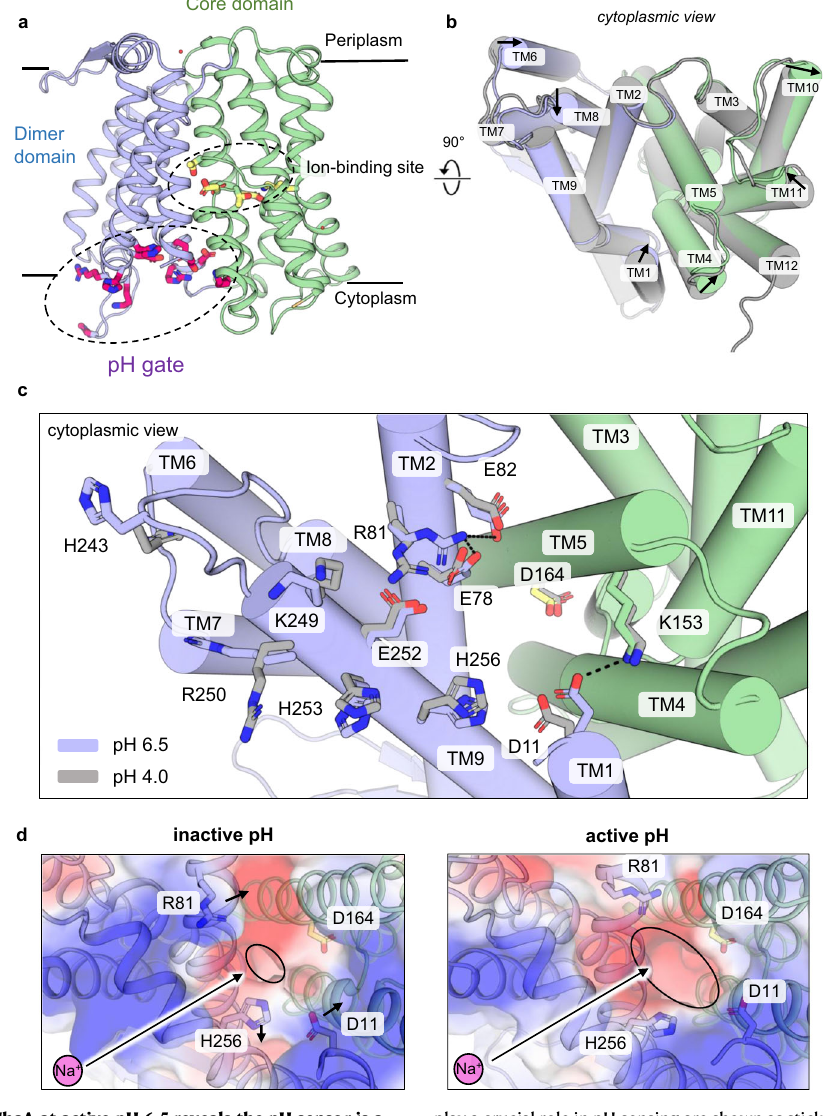
playa crucialroleinpH-sensing are shown assticks and salt-bridges indicatedbya dashedline.ThepH4.0structure(PDBID:4AU5,grey)issuperimposedagainstthe monoLCP-NhaA structure (coloured). d Electrostatic surface representation look- ing at the inside-open ion-binding funnel of Ec NhaA, comparing the dimerLCP- NhaAstructure(PDB ID: 4AU5) atinactive pH4.0 (left) againstthe monoLCP-NhaA structure atpH 6.5 (right). Arrows indicate the rearrangements of indicated amino acids. The ion-binding funnel is marked by a black ellipsis. It notably widens at active